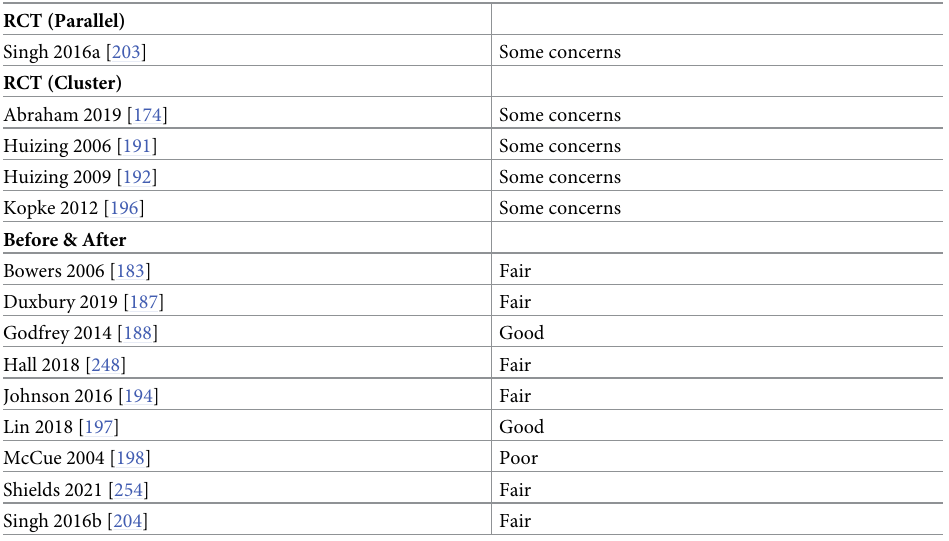
Table 5. Summary risk of bias for studies included in the meta-analysis.